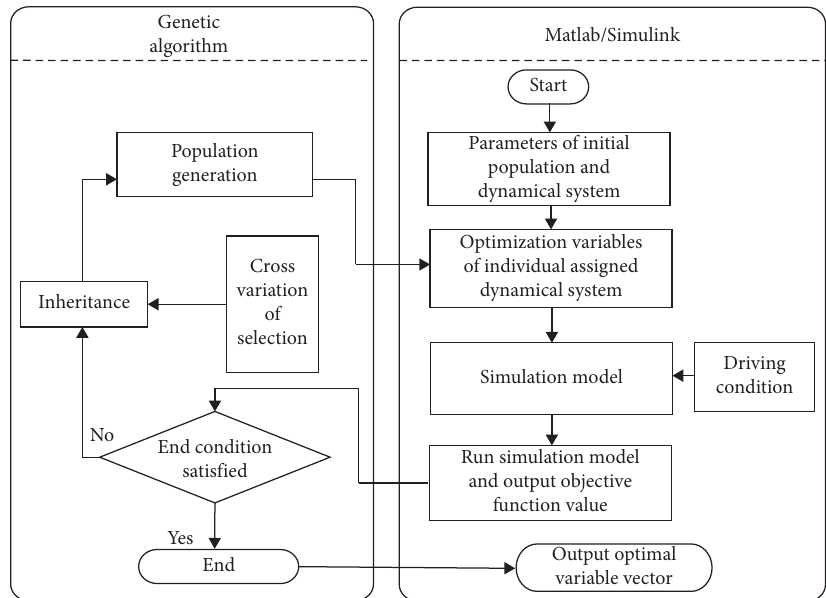
Figure 3: Genetic algorithms optimization flowchart.